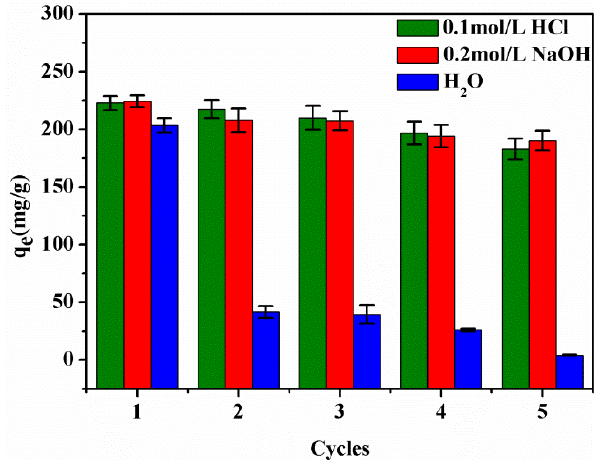
Figure 9. ATR-FTIR of SPEN-CTAB-0% before and after adsorption and desorption.